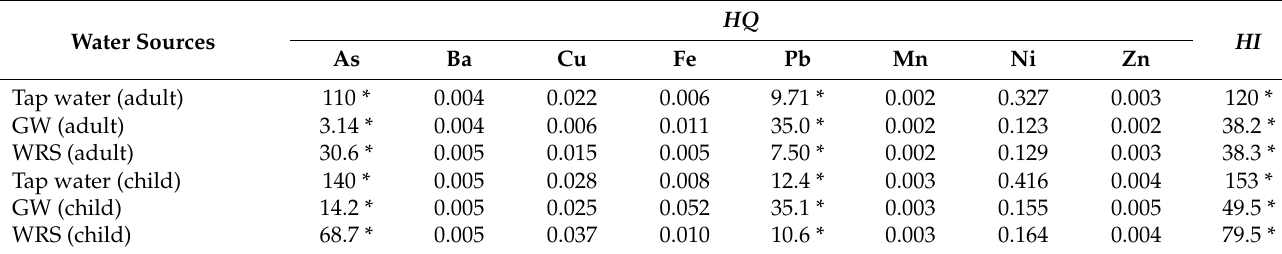
Table 9. Mean non-CR parameters ( HQ and HI ) of HMMs in the